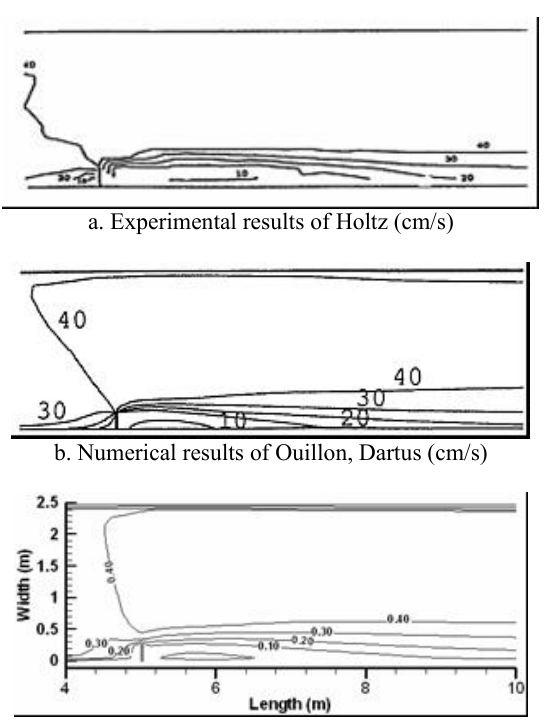
Fig.2 Isolines of water elevations around the groyne